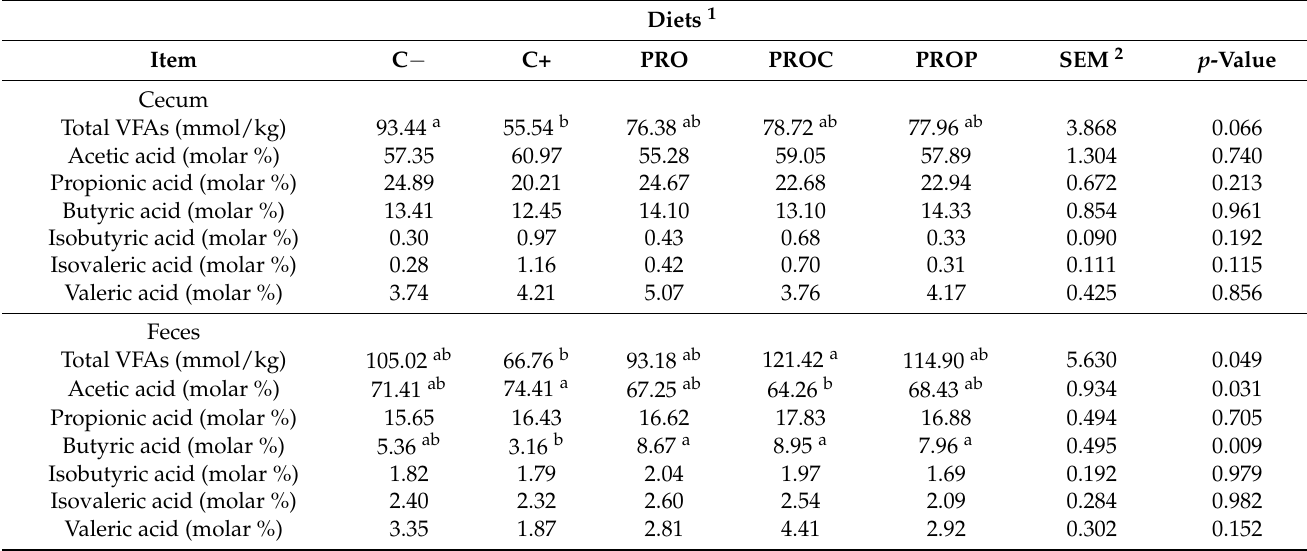
Table 4. Concentration of volatile fatty acids (VFAs) and fermentation profile in cecum and feces from piglets fed the experimental